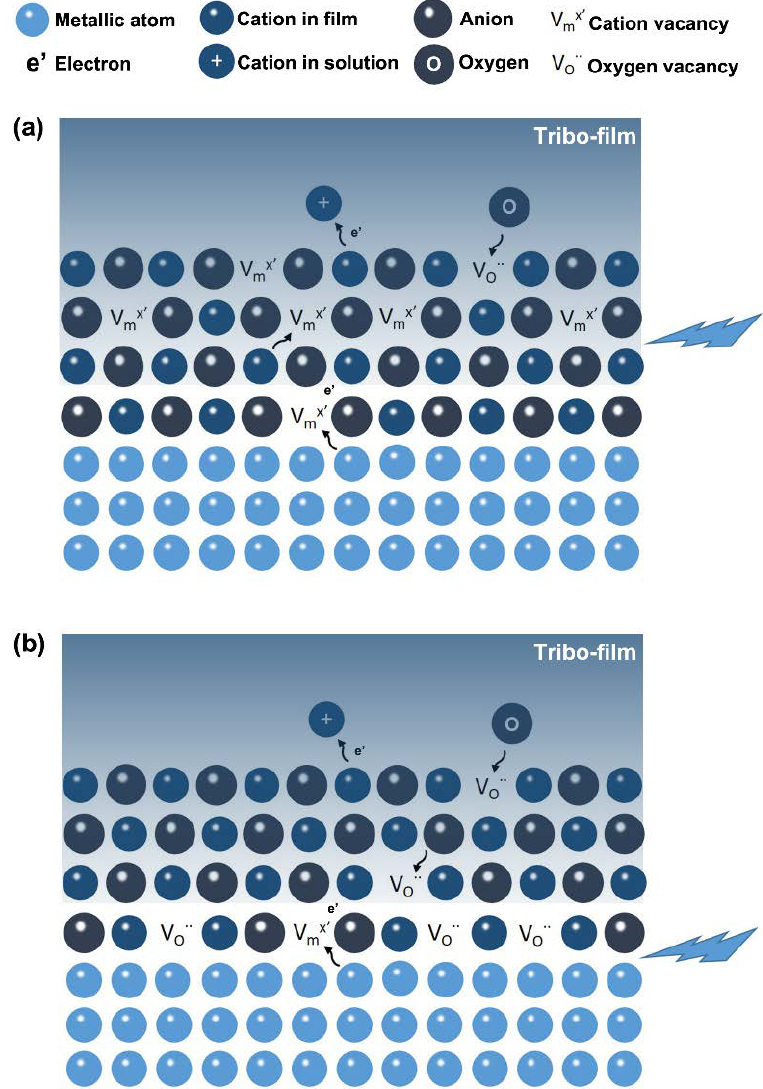
Figure 15. Schematic illustrations of interface structure of growing passive film in ( a ) cationic diffusion dominated growth and ( b ) anionic diffusion dominated growth.